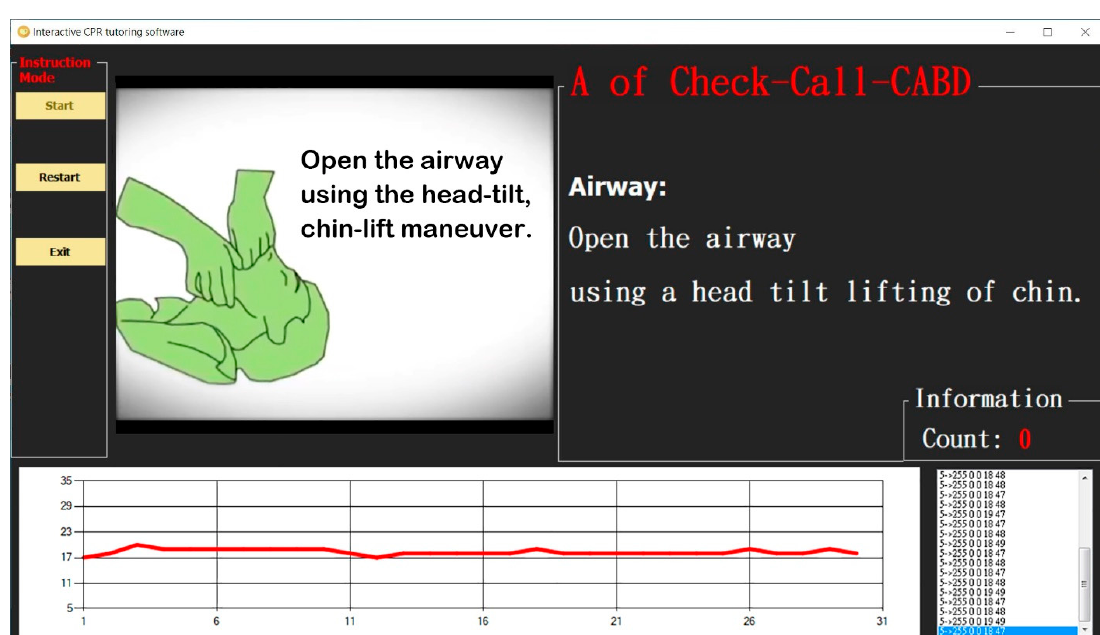
Figure 14. The user interface of the instruction mode.